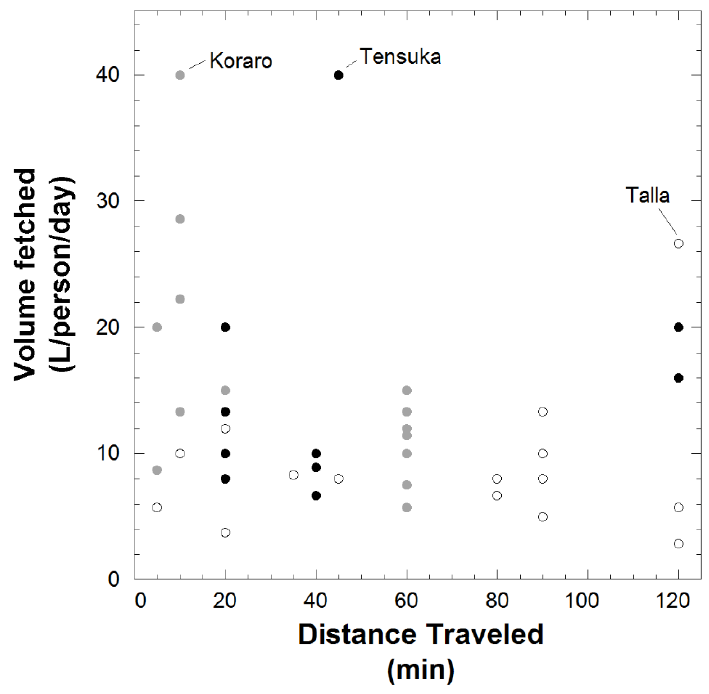
Figure 5 . Volume of water fetched with respect to distance traveled.